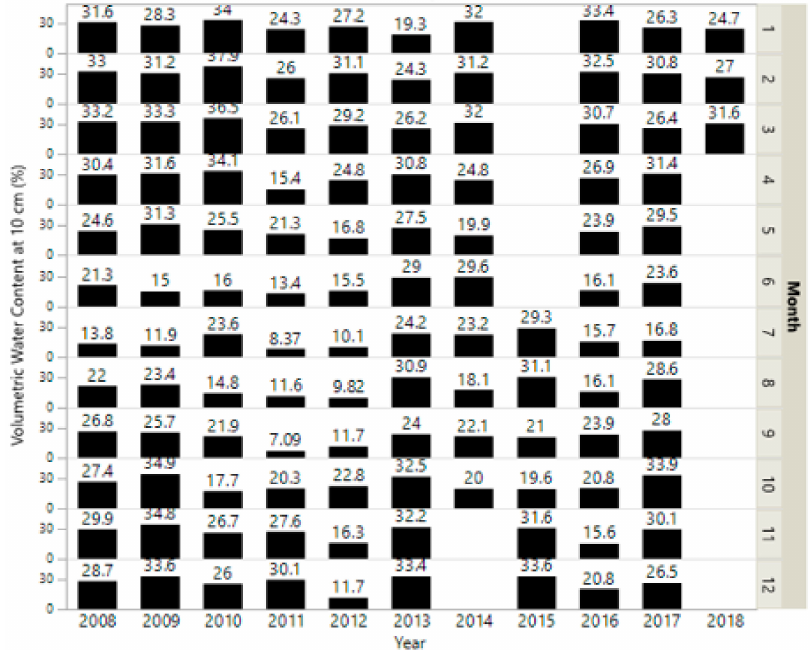
Figure A3. Monthly average volumetric water content (%) at 10 cm depth by year.